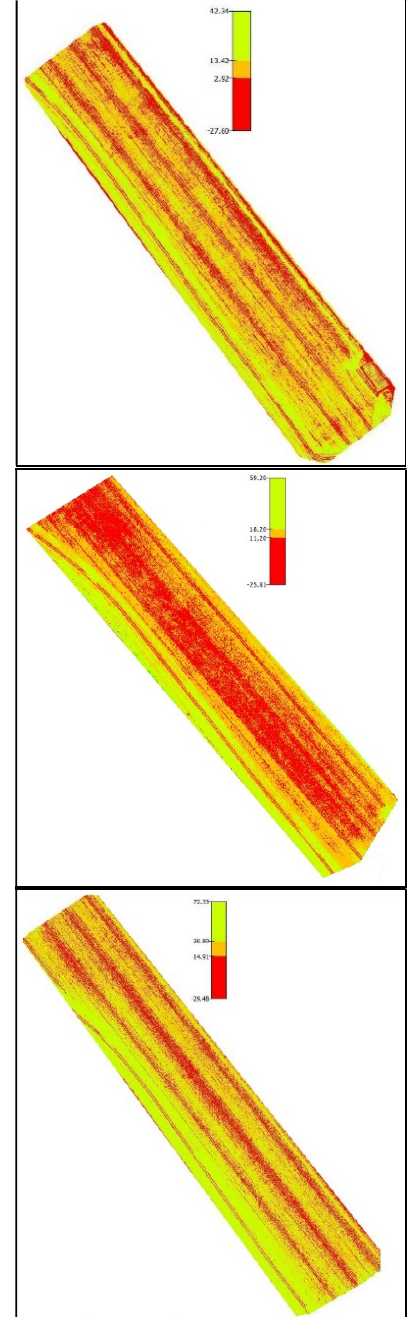
Figure 2 – TGI maps for wheat crops (A – germinating, B – flowering, C –